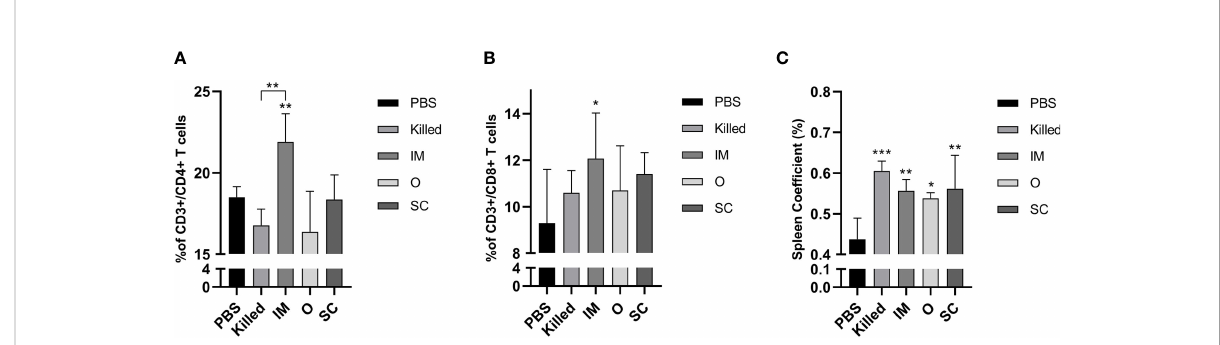
FIGURE 3 Cellular immune responses of vaccinated mice. Percentage of CD3+/CD4+ (A) and CD3+/CD8+ (B) T cells in spleen detected by fl ow cytometry at day 28 post-immunization. The spleen coef fi cient (C) was calculated by spleen weight (g)/mice weight (g). Signi fi cance was analyzed using 1-way ANOVA and Tukey ’ s multiple comparisons test. *p<0.05,**p<0.01,***p<0.001.